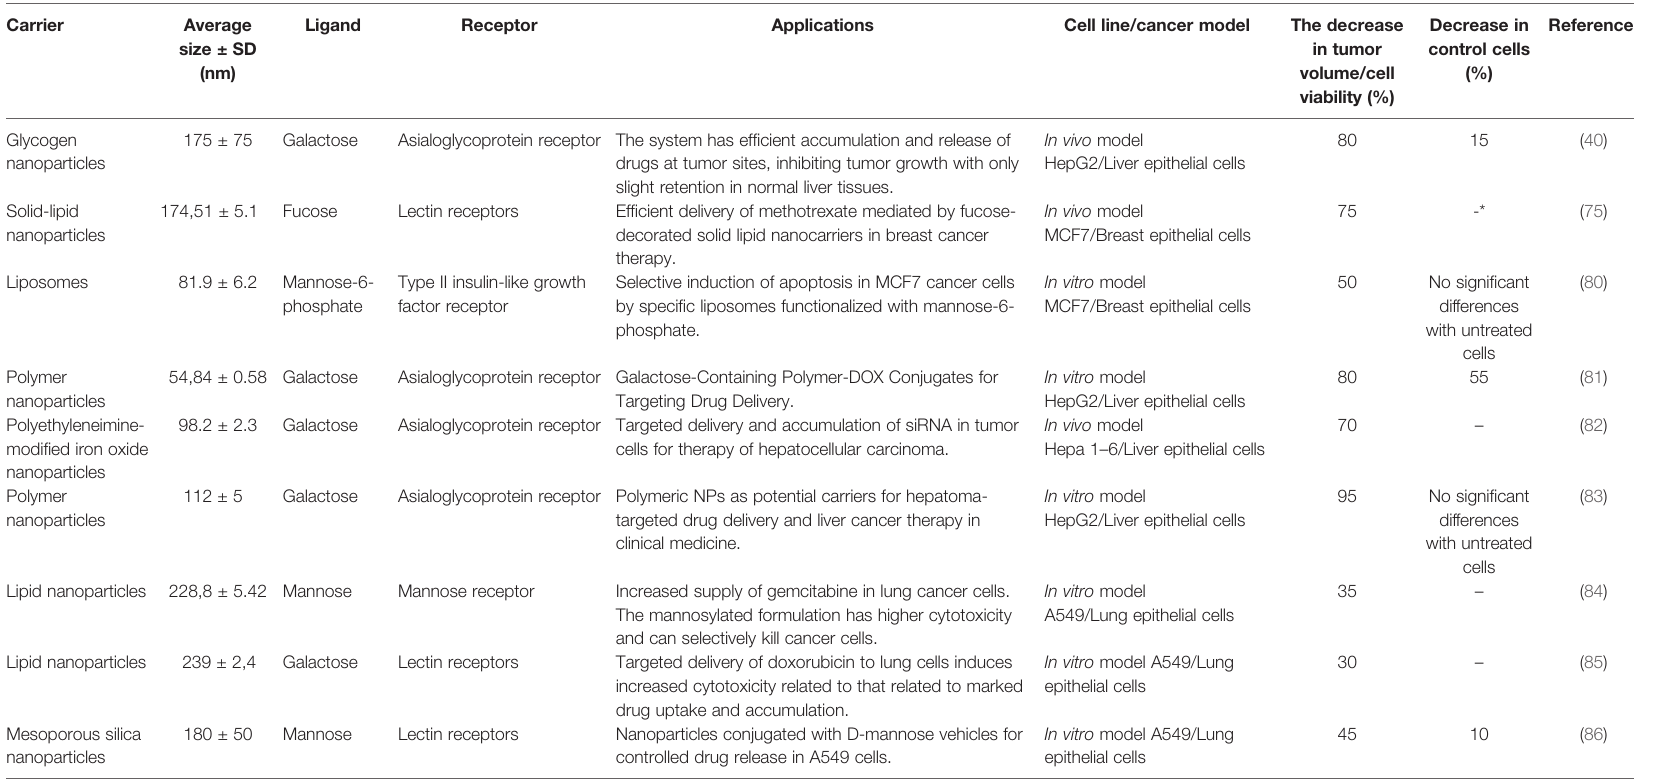
TABLE 1 | Applications of the recent glycosylated nanoparticles for drug delivery in cancer